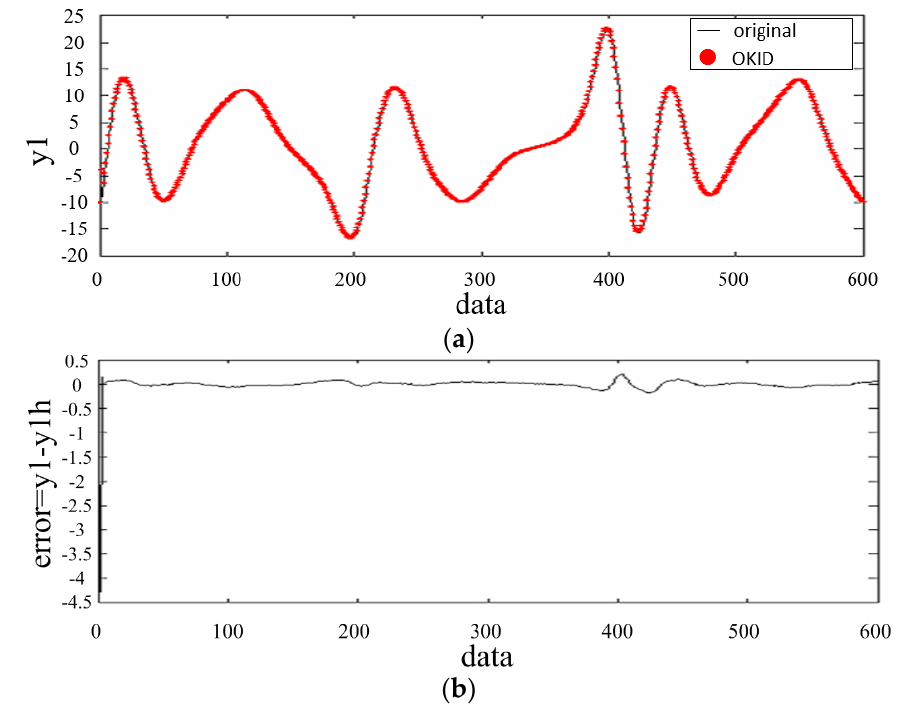
Figure 4. ( a ) Trajectories of y 1 ( t ) and ˆ y 1 ( t ) ; ( b ) Data of output error (cid:101) y 1 ( t ) .